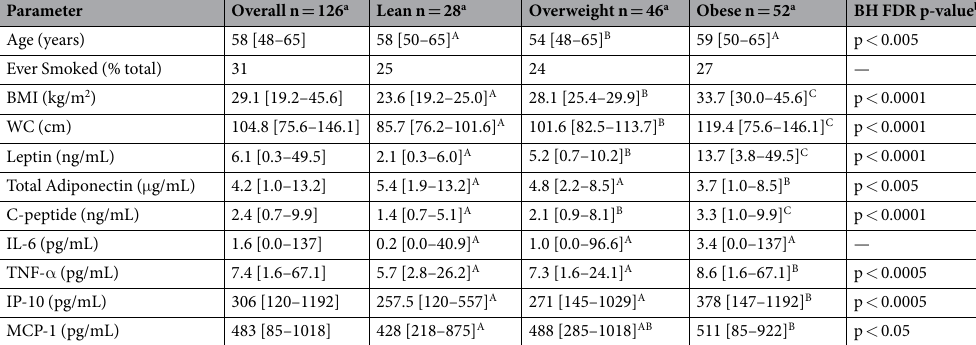
(Table 2). For several traits (i.e., BMI, WC, and leptin) lipidomic profiles accounted for over 60% of the variation in the samples (Table 2). Lipidomic profiles accounted for roughly 40% of the variation in total-adiponectin